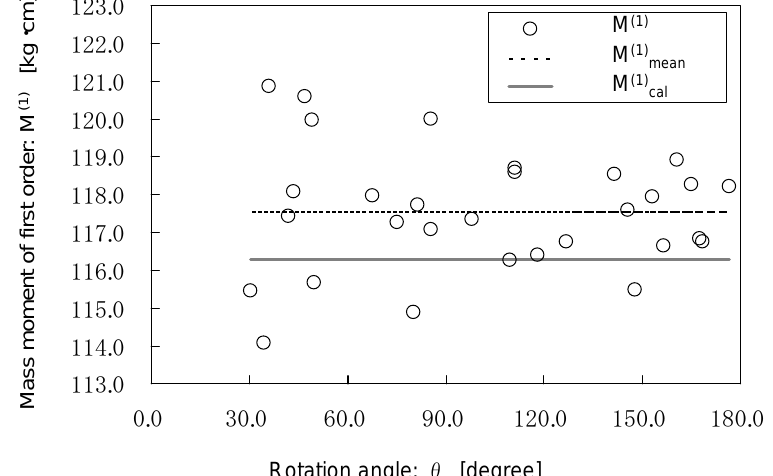
Figure 4. Relationship between the 30 measured values of M (1) , their mean value M (1) and the calibrated value M (1)